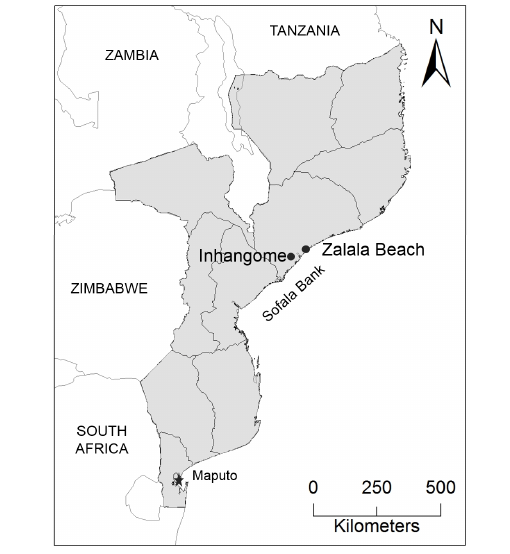
Fig. 1 . Location of the research communities, Inhangome and Zalala Beach, in